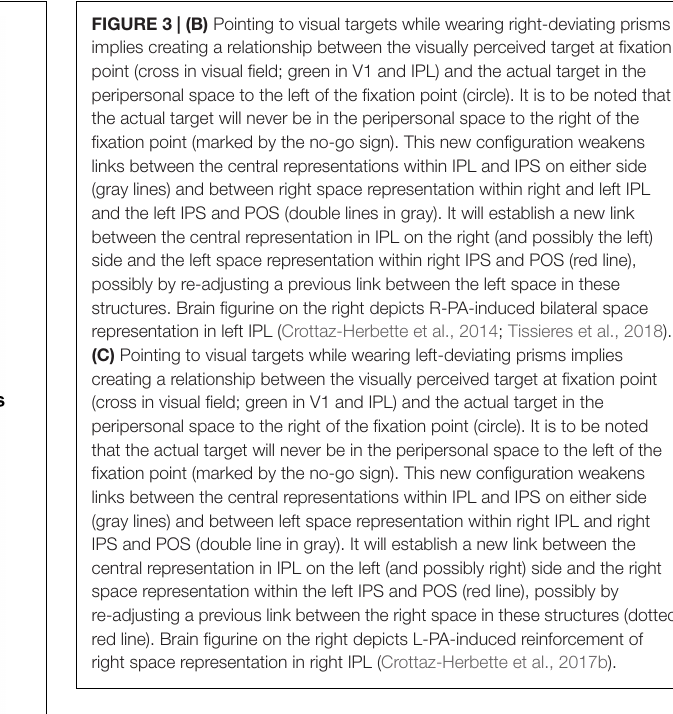
FIGURE 3 | (B) Pointing to visual targets while wearing right-deviating prisms implies creating a relationship between the visually perceived target at fixation point (cross in visual field; green in V1 and IPL) and the actual target in the peripersonal space to the left of the fixation point (circle). It is to be noted that the actual target will never be in the peripersonal space to the right of the fixation point (marked by the no-go sign). This new configuration weakens links between the central representations within IPL and IPS on either side (gray lines) and between right space representation within right and left IPL and the left IPS and POS (double lines in gray). It will establish a new link between the central representation in IPL on the right (and possibly the left) side and the left space representation within right IPS and POS (red line), possibly by re-adjusting a previous link between the left space in these structures. Brain figurine on the right depicts R-PA-induced bilateral space representation in left IPL (Crottaz-Herbette et al., 2014; Tissieres et al., 2018). (C) Pointing to visual targets while wearing left-deviating prisms implies creating a relationship between the visually perceived target at fixation point (cross in visual field; green in V1 and IPL) and the actual target in the peripersonal space to the right of the fixation point (circle). It is to be noted that the actual target will never be in the peripersonal space to the left of the fixation point (marked by the no-go sign). This new configuration weakens links between the central representations within IPL and IPS on either side (gray lines) and between left space representation within right IPL and right IPS and POS (double line in gray). It will establish a new link between the central representation in IPL on the left (and possibly right) side and the right space representation within the left IPS and POS (red line), possibly by re-adjusting a previous link between the right space in these structures (dotted red line). Brain figurine on the right depicts L-PA-induced reinforcement of right space representation in right IPL (Crottaz-Herbette et al.,